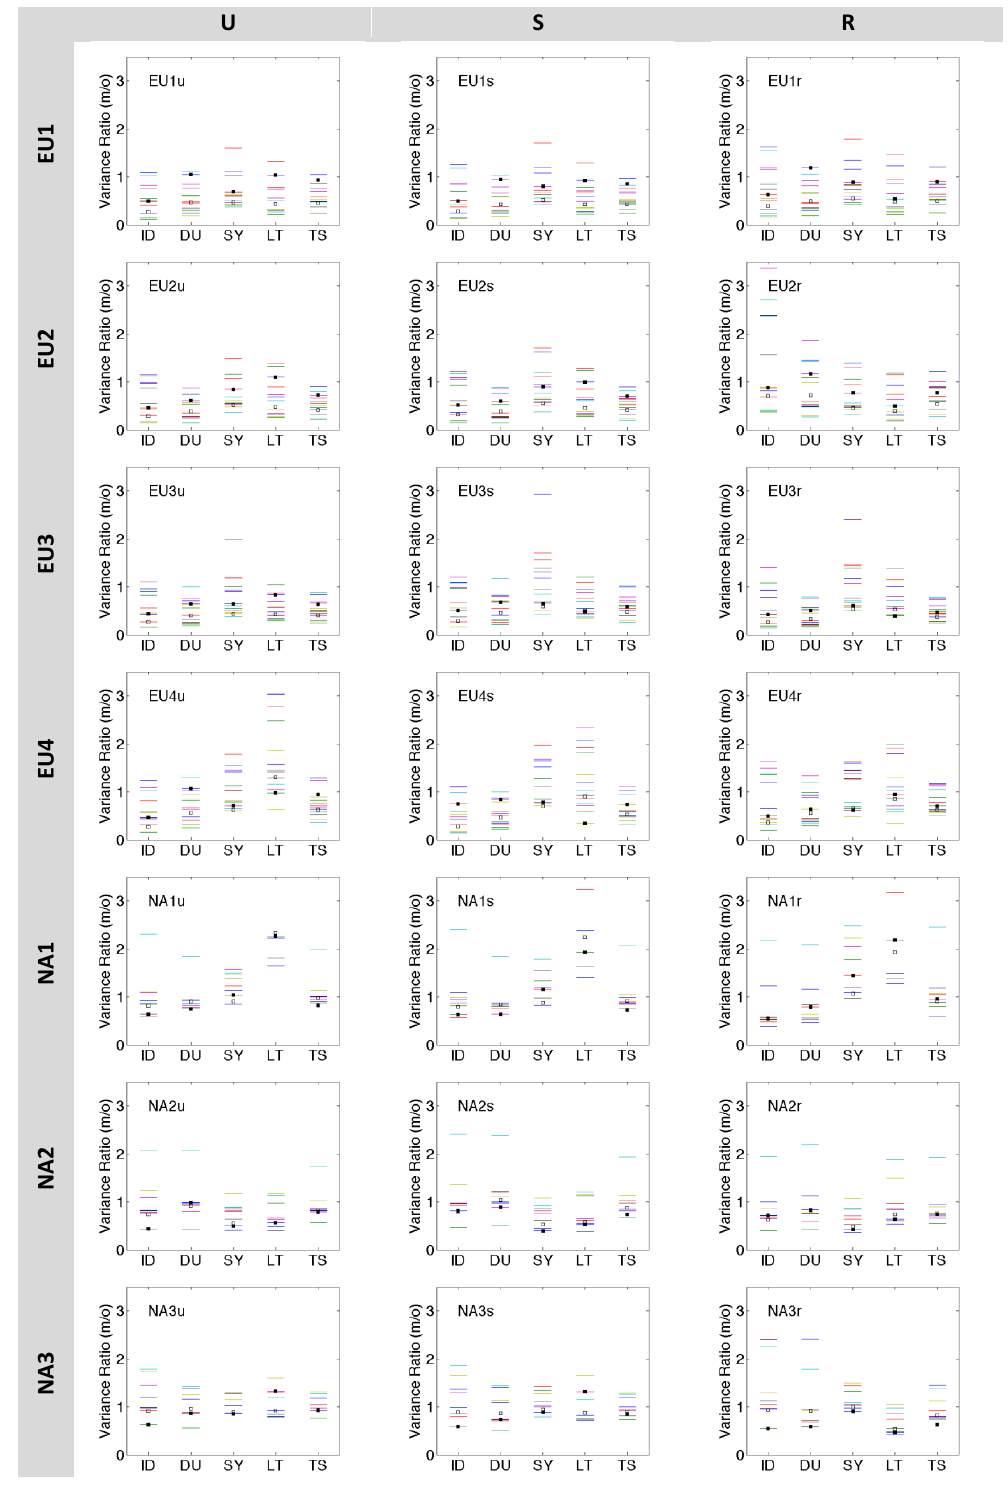
Fig. 7b. Properties of the spectrally decomposed modelled time-series of ozone, into four (ID, DU, SY, LT) components, versus their observed counterparts. Results are shown for all seven subdomains and three ozone aggregation types. For all plots, the square marker reflects the mm, the filled square the kz, the red circle the observations and the coloured lines the individual models. (b) Variance ratio: the modelled explained variance is expressed in terms of the observed explained variance by the use of their ratio. The variance ratio for the mm (squares) is variable and in many cases far from unity. Using the least RMSE spectral component results in a clear improvement of the variance ratio. www.atmos-chem-phys.net/13/7153/2013/ Atmos. Chem. Phys., 13, 7153–7182,